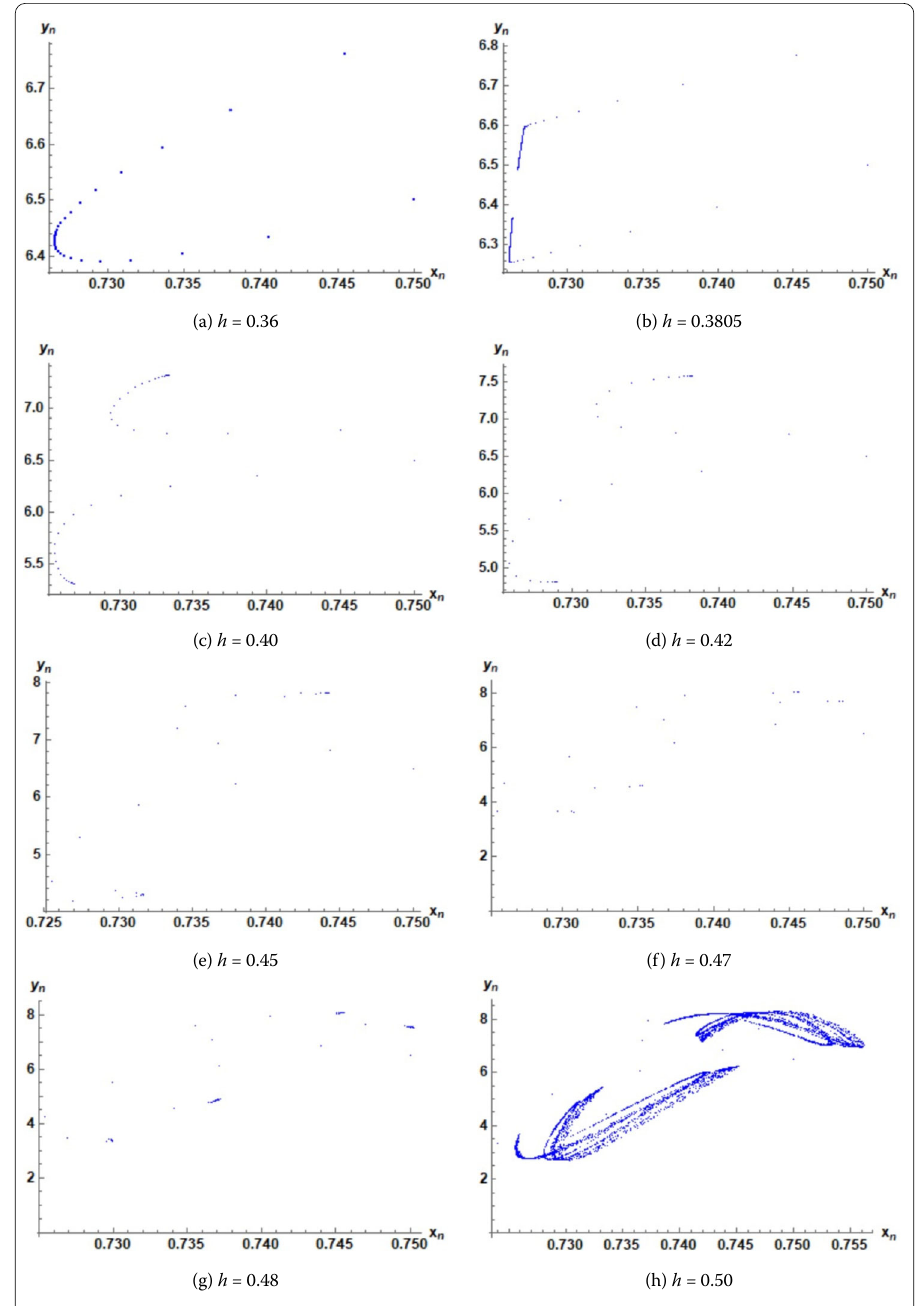
Figure 4 Phase portraits for model (2) at different values of h with ( a , b , c , d , α , β ) = (0.4,2,5.4,0.113,0.012,6) with initial conditions (